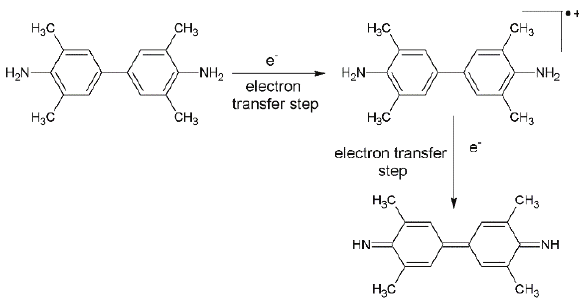
Figure 15: Mechanism of oxidation of TMB [122].